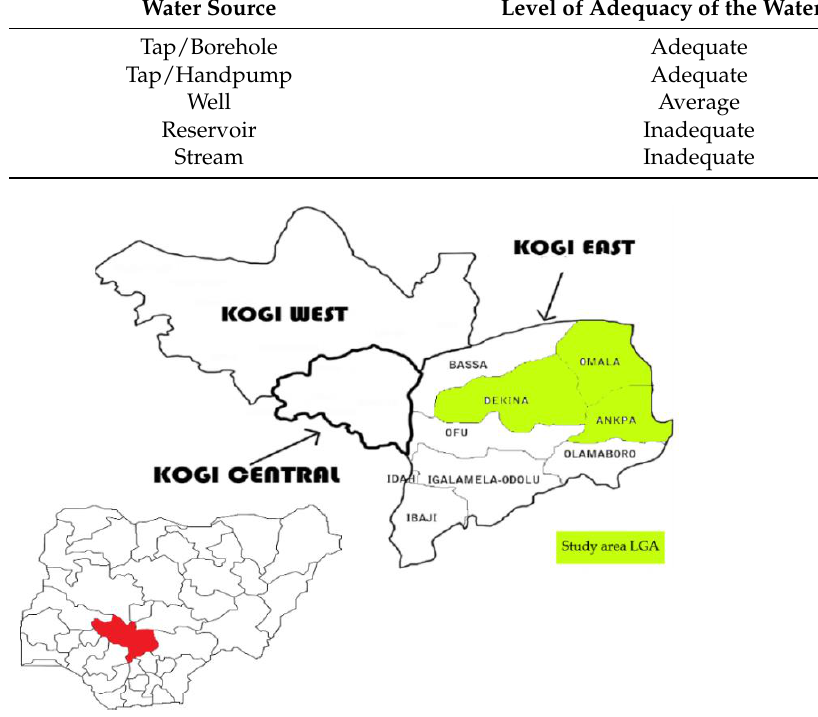
Figure 2. Map of Kogi state showing the study